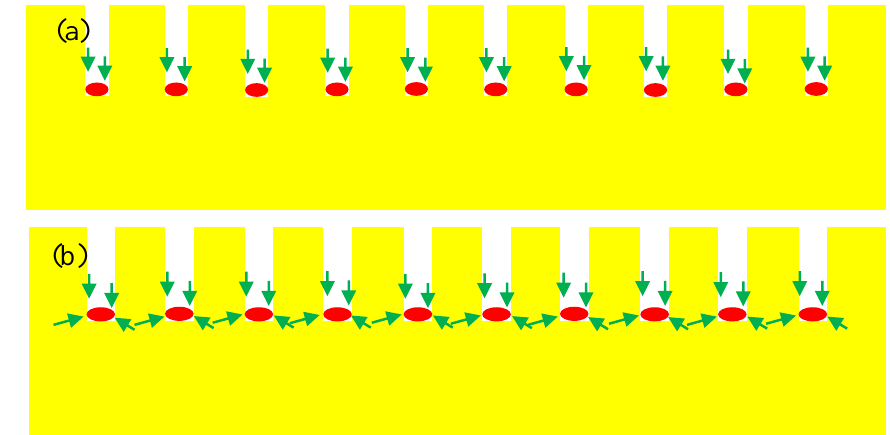
Figure 3: Schematic diagram showing favored etching directions of c-Si: (a) under low